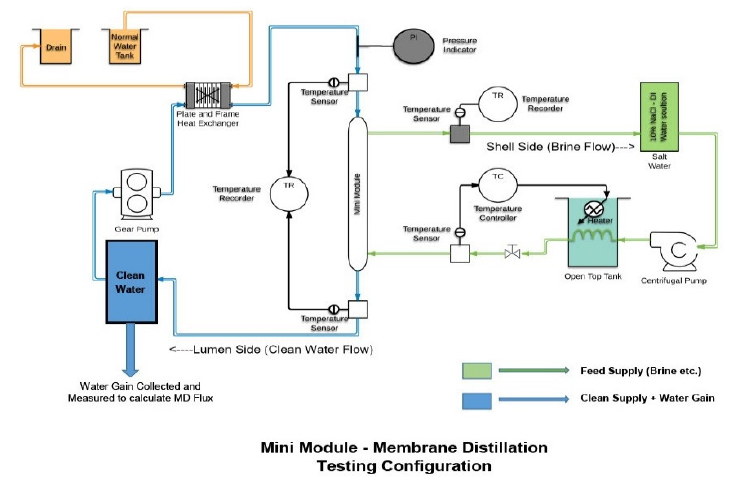
Figure 2. Schematic of the apparatus used for membrane distillation.